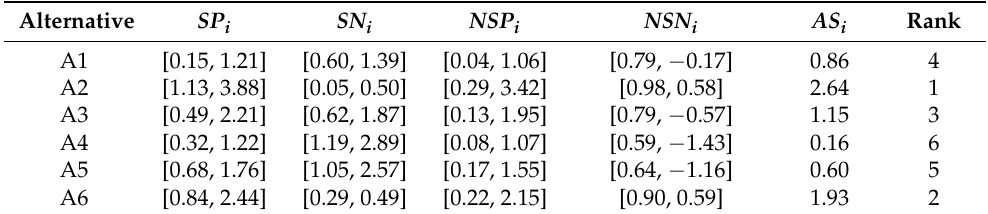
Table 6. Results of the R-EDAS method and rankings of the FWS alternatives.